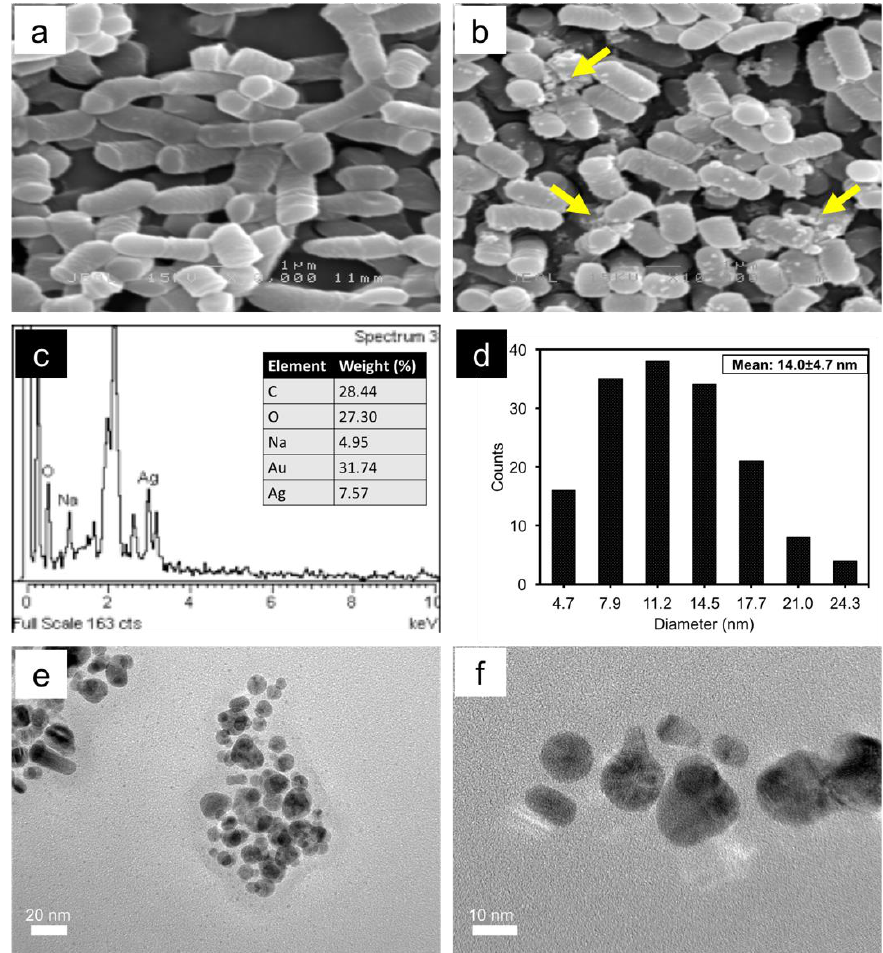
Figure 6. Scanning electron microscope (SEM) micrograph of L. plantarum TA4 ( a ) unexposed to Ag + ( b ) exposed to Ag + . SEM scale bar = 1 µm. ( c ) Energy dispersive X-ray (EDX) spectra of L. plantarum TA4 exposed to Ag + . ( d ) The particles size distribution of biosynthesized AgNPs. ( e ) High-resolution transmission electron microscope (HR-TEM) micrographs of biosynthesized AgNPs at scale bar = 20 nm. ( f ) HR-TEM micrographs of biosynthesized AgNPs at scale bar = 10 nm.